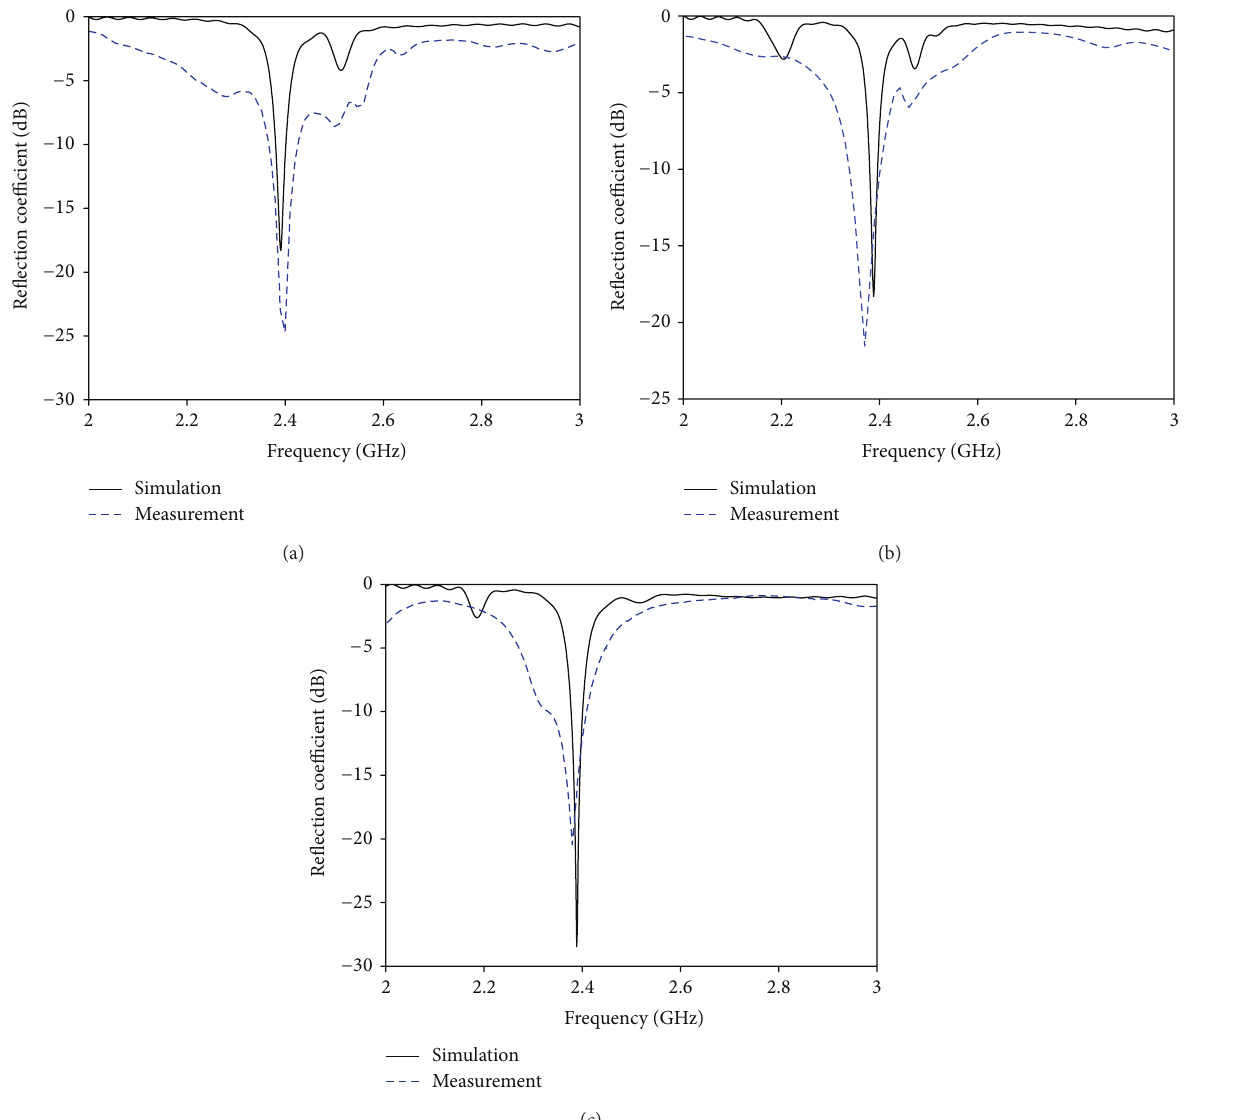
Figure 7: Measured and simulated reflection coefficient of the proposed antenna. (a) R-RFS B and C are ON. (b) R-RFS A, B, and C are ON. (c) R-RFS A and C are ON. The R-RFS that was not mentioned is in OFF state.